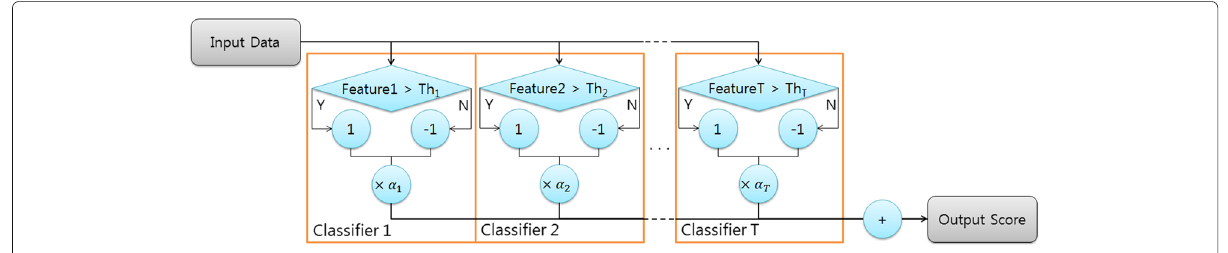
Fig. 2 Ensemble of linear classifiers